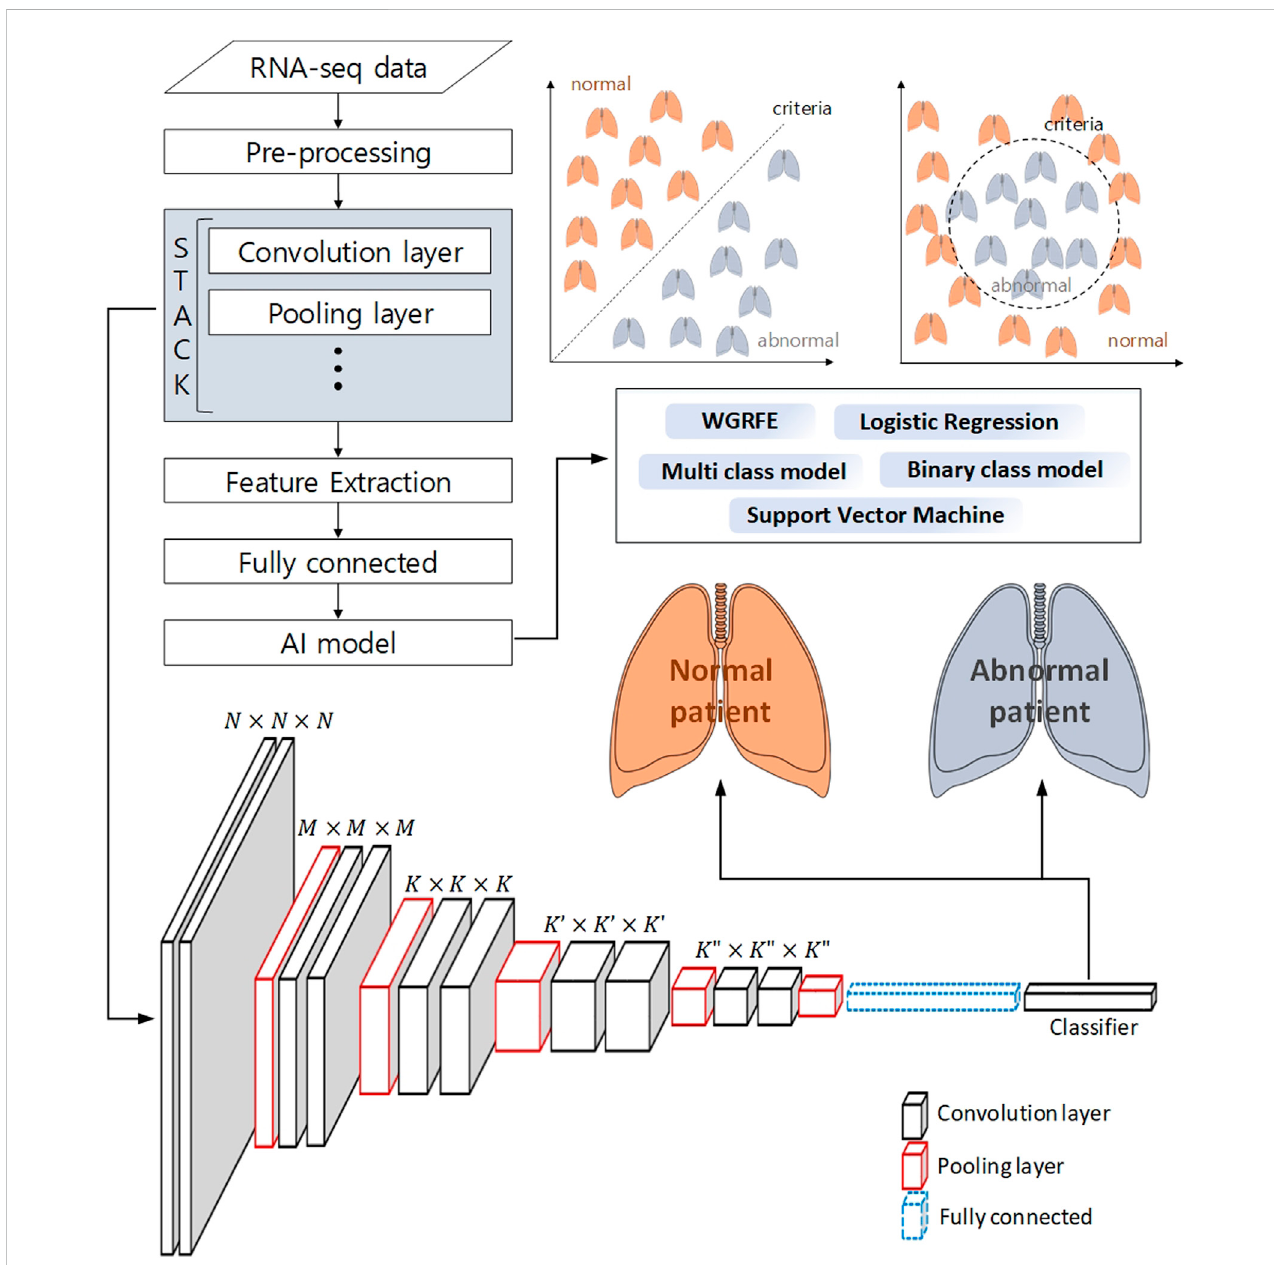
FIGURE 3 Schematic work fl ow of analysis to classify a normal patient from an abnormal patient using deep learning and machine learning. The pre-processed RNA-seq data is subjected to feature extraction using a neural network, and machine learning-based binary classi fi cation is performed using these features.